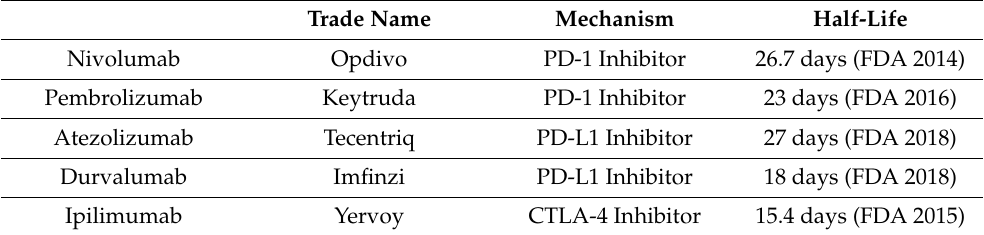
Table 1. “Examples of FDA-approved immunotherapies and their half-lives”. Table 1. Examples of FDA-approved immunotherapies and their